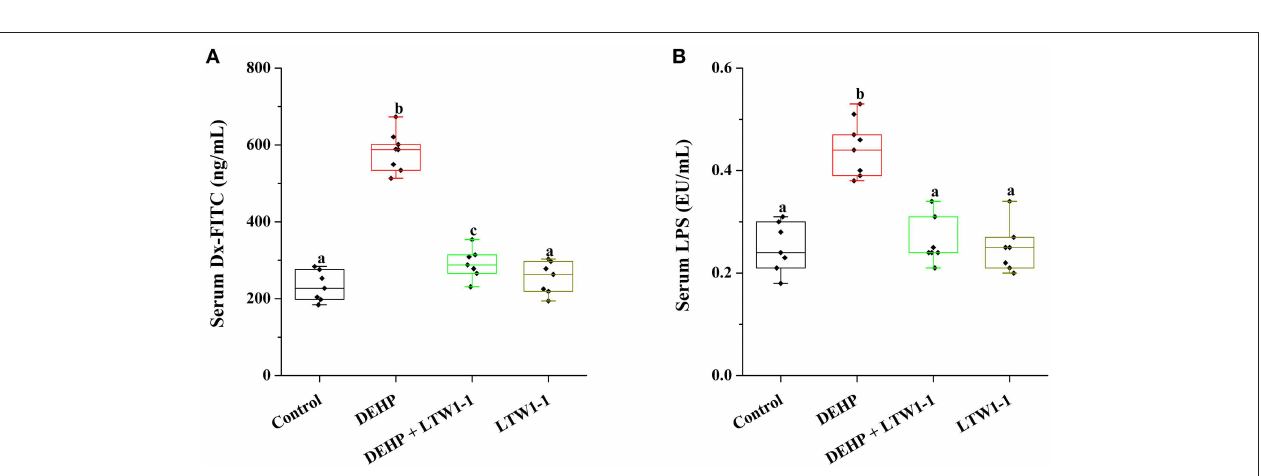
FIGURE 4 | Effects of L. plantarum TW1-1 treatment on intestinal permeability in DEHP-exposed mice. (A) Serum Dx-FITC levels. (B) Serum LPS levels. The LPS levels were detected by ELISA. The data are expressed as mean ± S.E.M. ( n = 7–8), different letters represent significant differences between groups by Tukey’s test ( P <